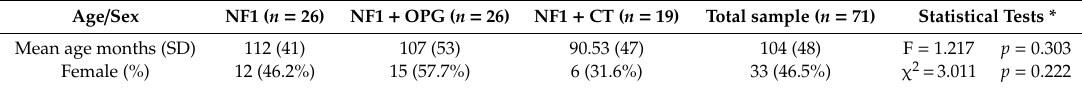
Table 4. Age and sex distribution among the three groups.